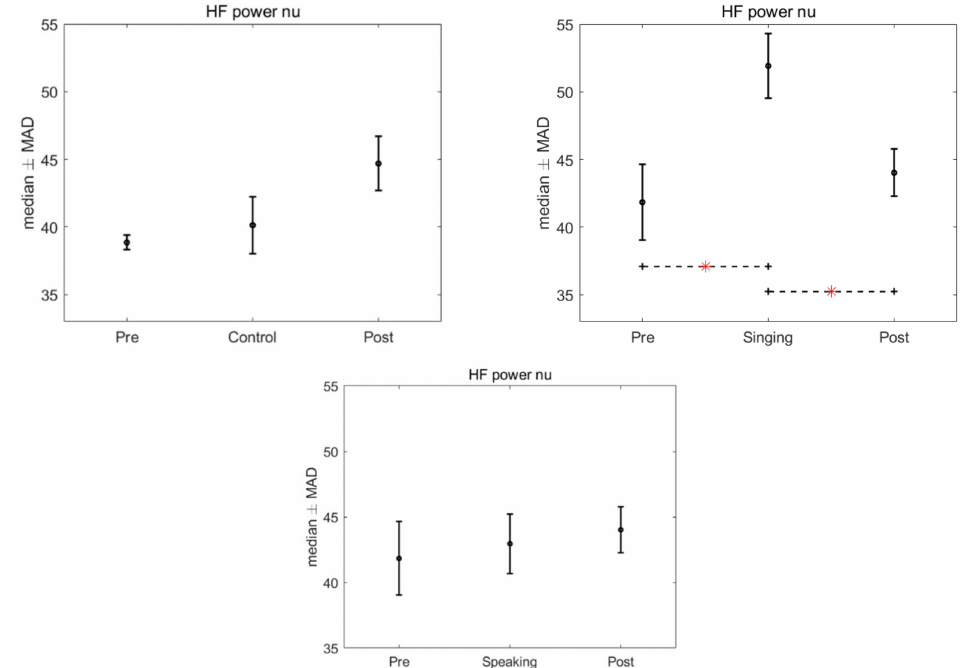
Figure 2. Median and MAD of HF power nu for the three time conditions related to control, singing, and speaking groups. The asterisk indicates the sessions that resulted significantly different after we used Bonferroni’s test for post hoc analysis.